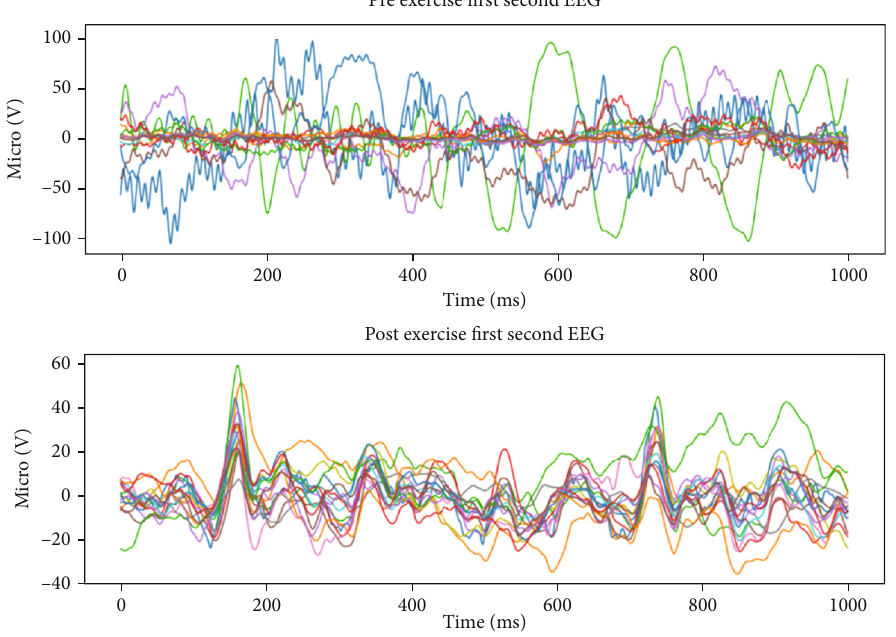
Figure 3: Pre and post exercise 16-channel EEG